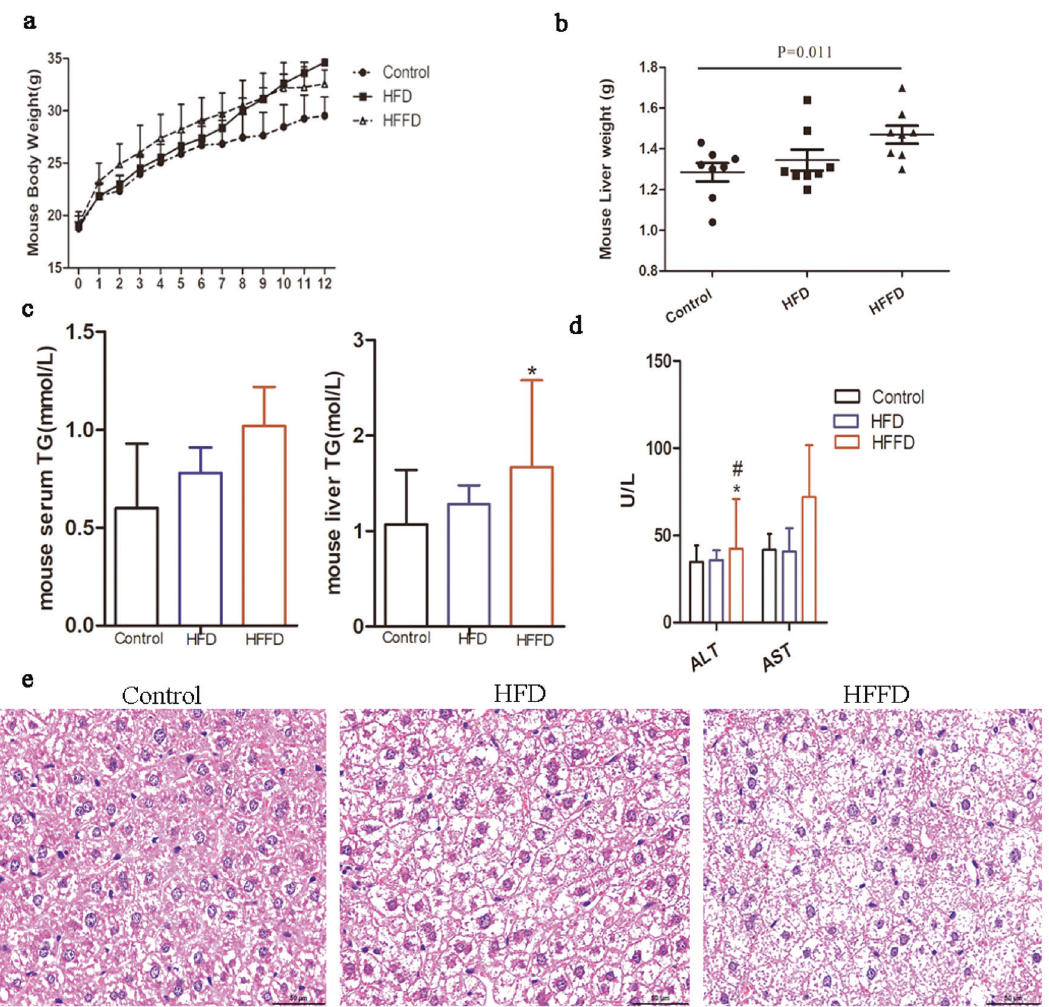
Fig. 2 Metabolic characterization in mice. a Body weight in mice with HFD, HFFD, or regular chow diet. b Liver weight in mice with HFD, HFFD, or regular chow diet. c Serum and liver TG in mice with HFD, HFFD, or regular chow diet, *compared to control, p < 0.05. d Liver enzyme in mice with HFD, HFFD, or regular chow diet, *compared to control, p < 0.05; # compared to HFD, p < 0.05. e H&E staining in